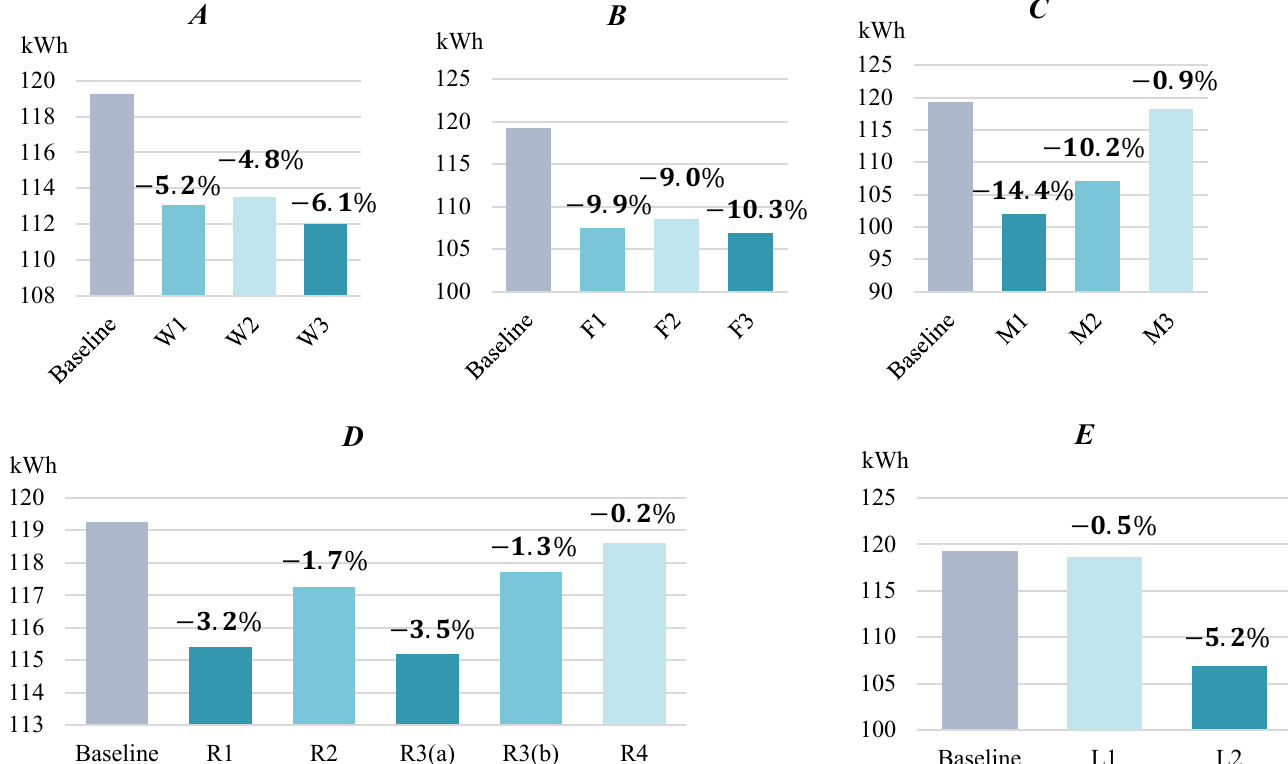
Figure 10. The aggregated cooling and dehumidification load of the single strategies against the SBC benchmark.